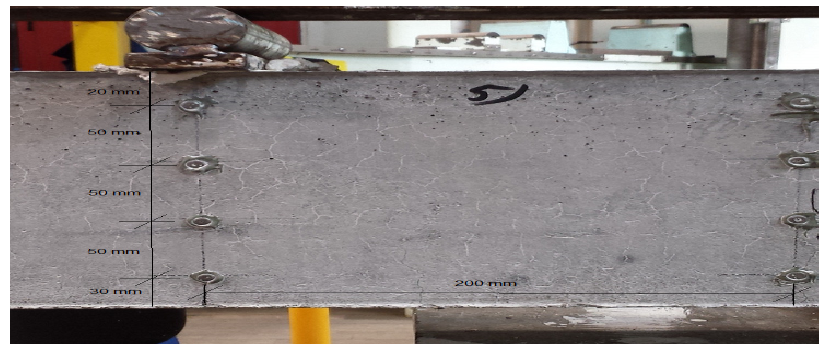
Figure 3. The arrangement of demecs on the surface of beams.